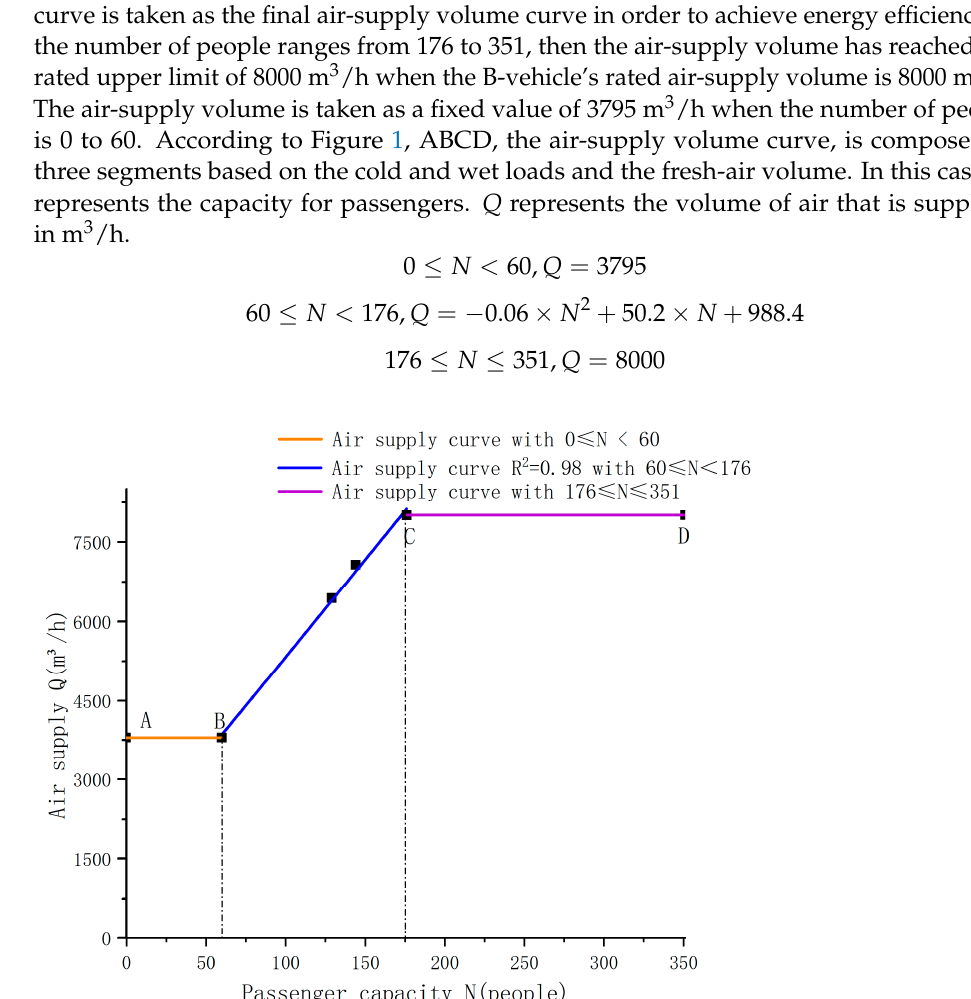
Table 4. Minimum air volume for each working condition.